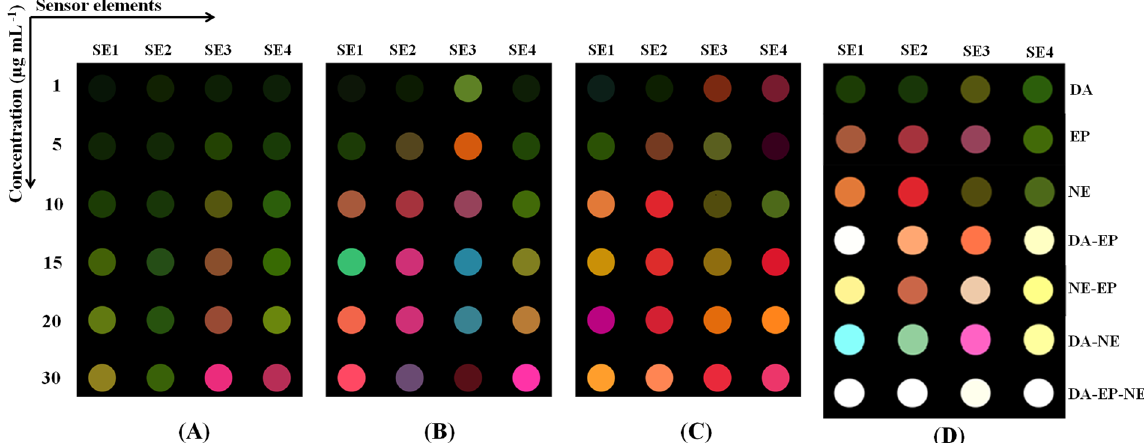
Figure 5. Unique color patterns as fingerprints for ( A ) DA, ( B ) EP and ( C ) NE at different concentrations (1–30 µ g mL − 1 ). ( D ) Sensor array responses for binary and ternary mixtures of the neurotransmitters at concentration of 10 µ g mL − 1 .